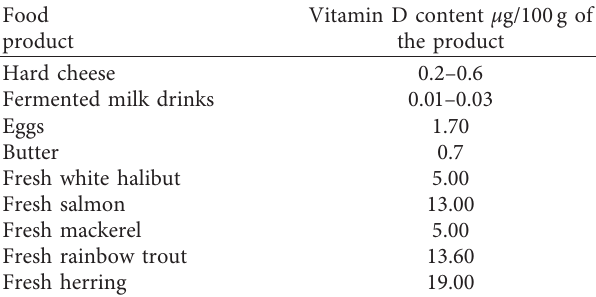
Table 3: Vitamin D content of selected food products